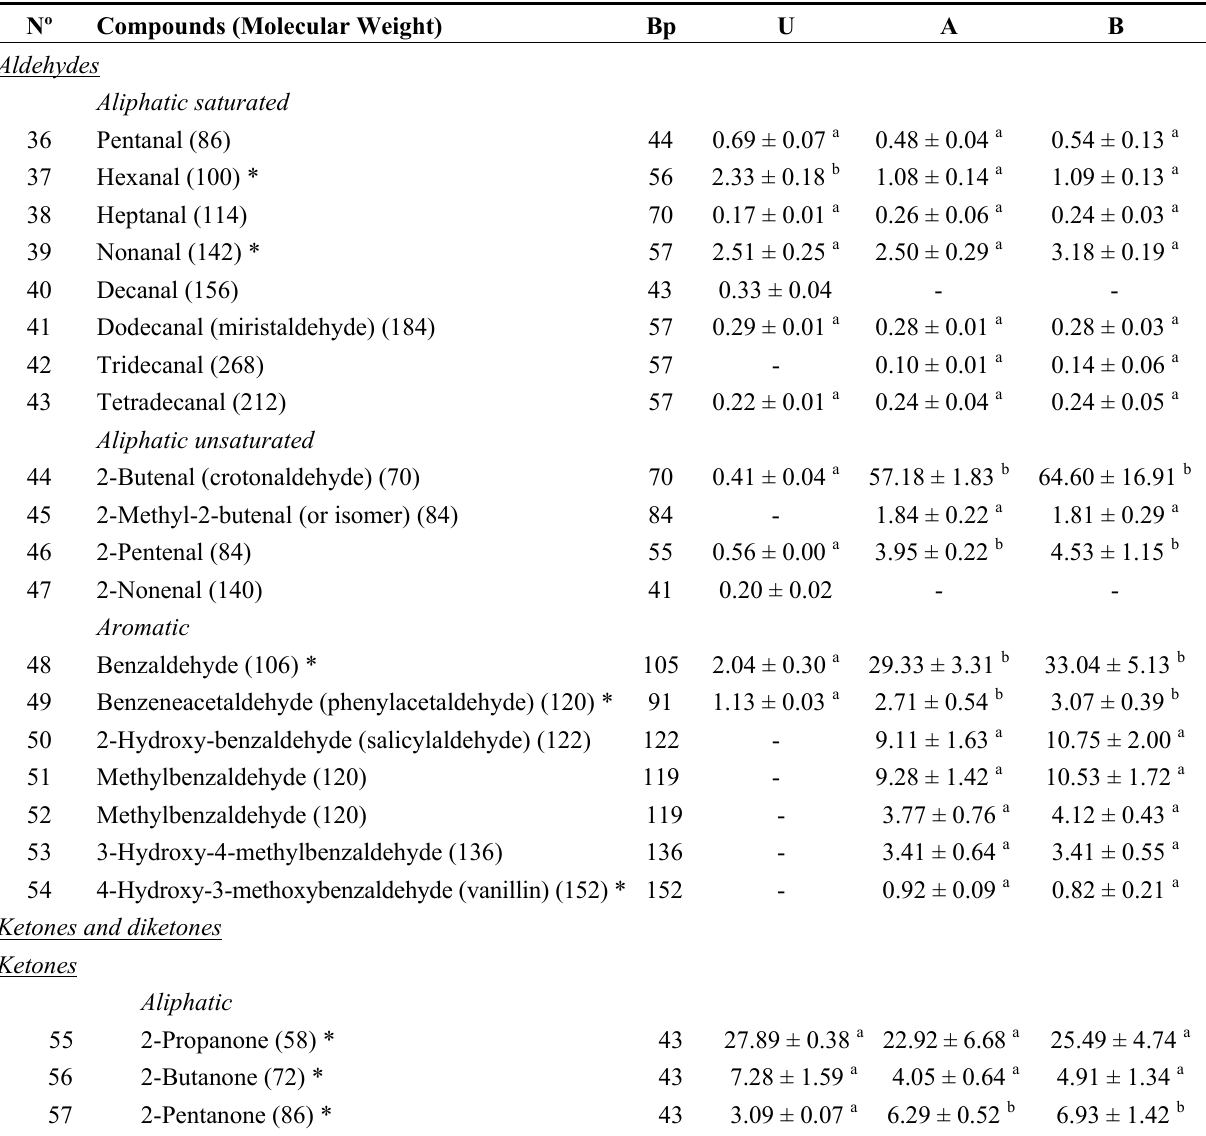
Table 2. Aldehydes, ketones and diketones detected in the headspace of the exterior region of unsmoked (U) and smoked (A and B) Herreño cheeses studied, together with their molecular weight, the base peak of their mass spectra (Bp), their abundance, expressed as average area counts of their mass spectra base peak divided by 10 5 , and standard deviation a